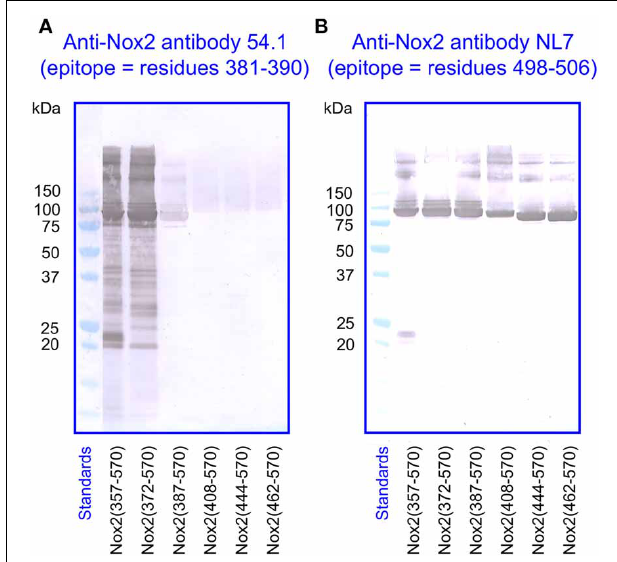
FIGURE 4 | Immunoblot of NusA-Nox2 fusion protein truncations using anti Nox2 monoclonal antibodies 54.1 and NL7. (A) The figure illustrates the fact that antibody 54.1 (its epitope represented by Nox2 residues 381–390) recognizes Nox2 truncations 357–570 and 372–570, and reacts weakly with truncation 387–570. (B) Antibody NL7 (its epitope represented by Nox2 residues 498–506) recognizes all truncations, from 357–570 to 462–570.